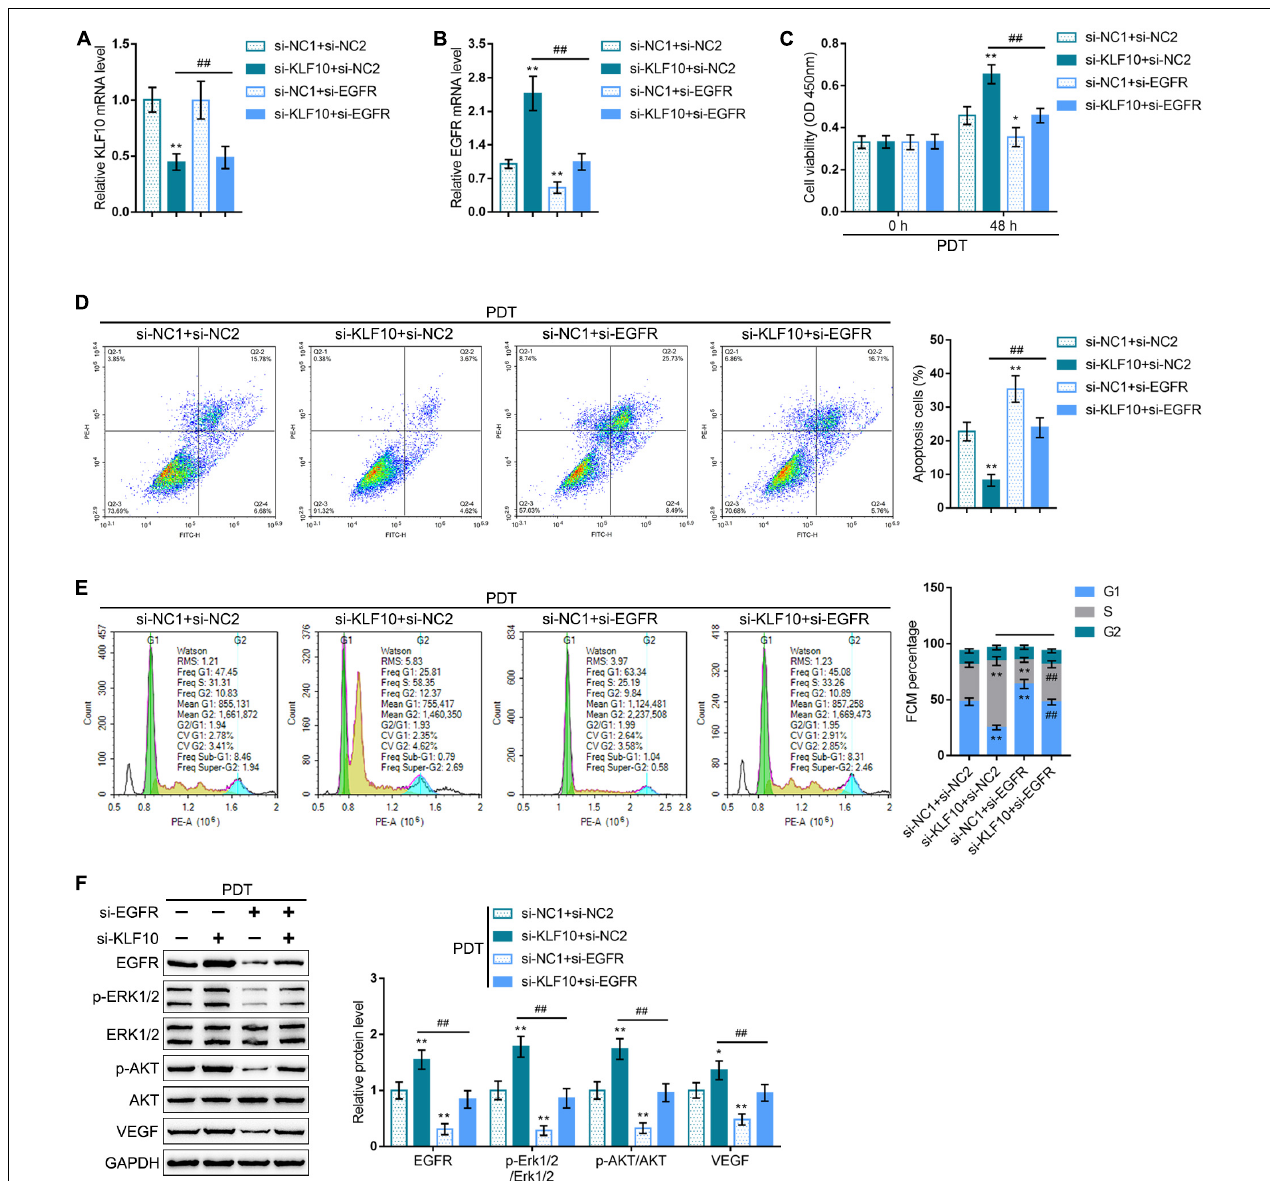
FIGURE 7 | KLF10 modulates PDT reversing cholangiocarcinoma gemcitabine resistance through EGFR. RBE-R cells were co-transfected with si-KLF10 and si-EGFR, exposed to PDT treatment, and examined for the mRNA expression of KLF10 (A) and EGFR (B) by real-time qPCR; cell viability by MTT assay (C) ; cell apoptosis by Flow cytometry (D) ; cell cycle distribution by Flow cytometry (E) ; the protein levels of KLF10, EGFR, p-Erk1/2, Erk1/2, p-Akt, Akt, and VEGF by Immunoblotting (F) . * P < 0.05, ** P < 0.01, compared with the si-NC1 + si-NC2 group; ## P < 0.01, compared with the si-KLF10 + si-NC2 group.